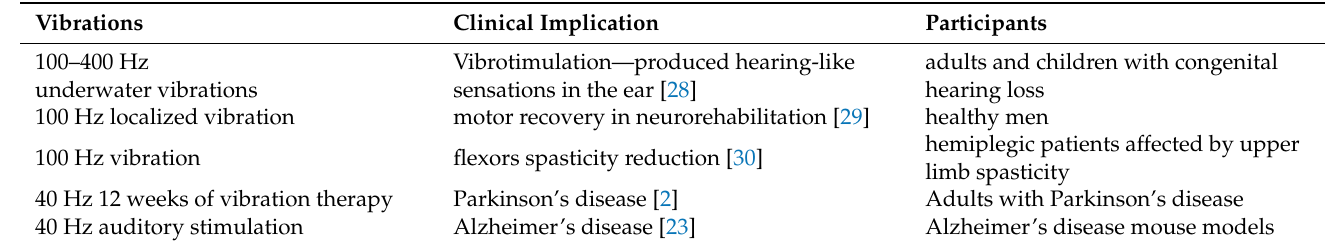
Table 1. The vibration research and clinical